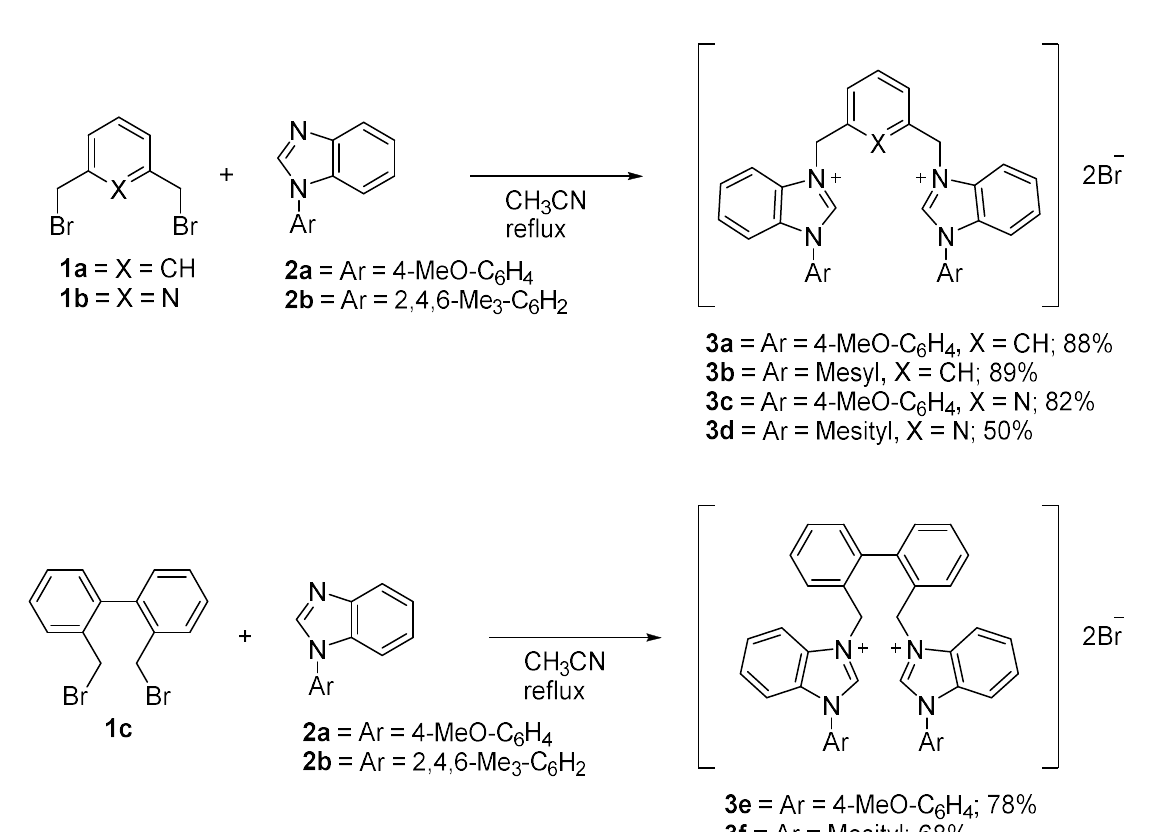
Scheme 1. Overview of the synthesis of bis-benzimidazolium salts 3